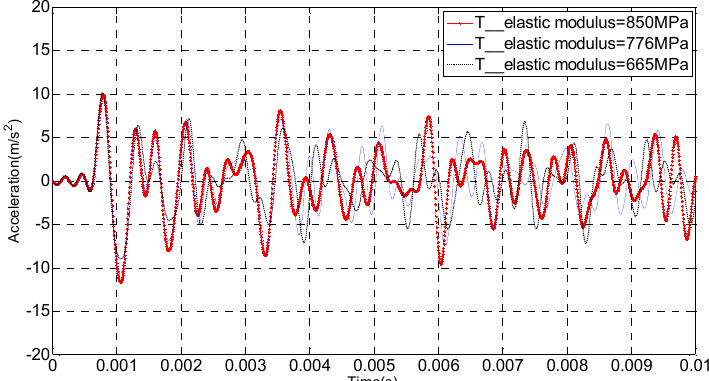
Figure 14. Effect of elastic modulus in the radial direction on wave behaviour in the orthotropic model.